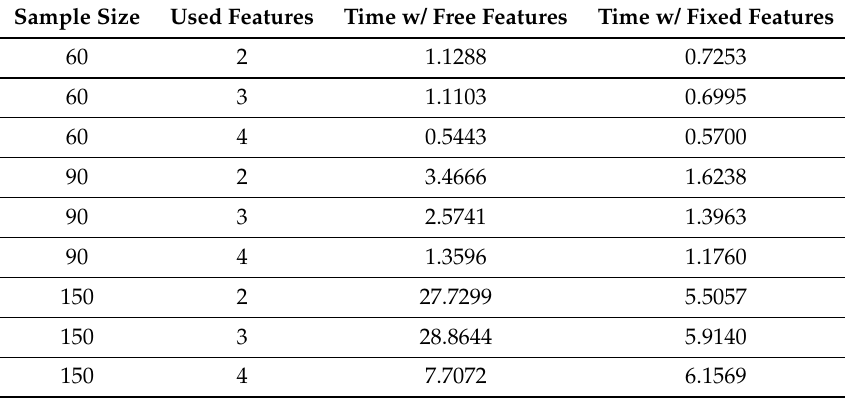
Table 1. Times table for a data set of 150 points and 4